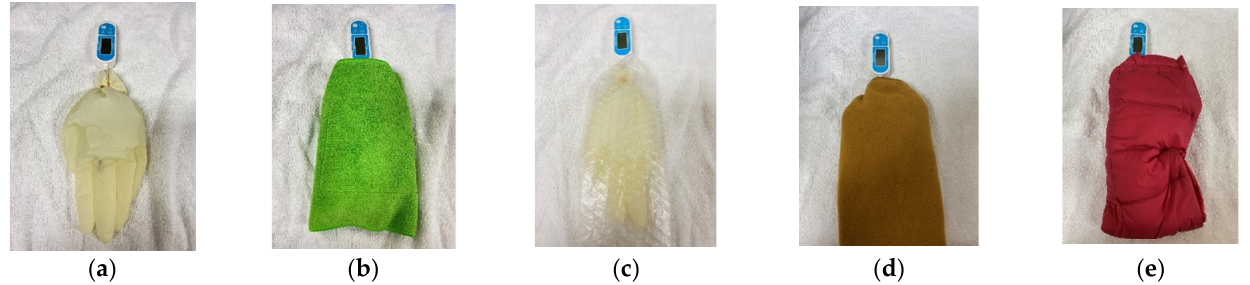
Figure 1. Examination of the heat insulating materials. Hot water at 39 °C was placed in a latex glove, and the temperature was measured once every 30 min from the start of measurement to 2 h later. ( a ) no cover, ( b ) bath towel, ( c ) bubble wrap, ( d ) bubble wrap and fleece, and ( e ) bubble wrap and down cloth.